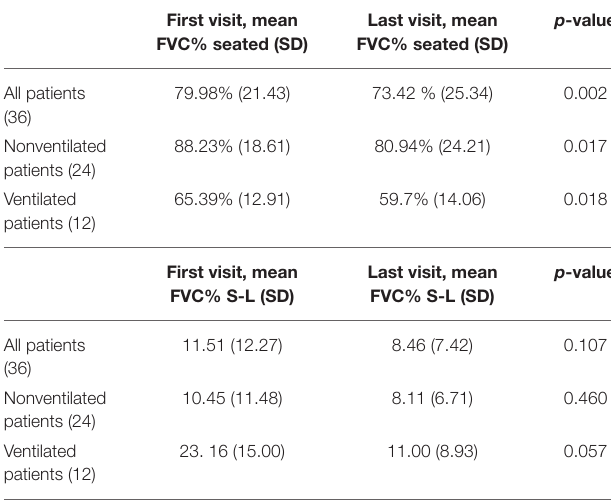
TABLE 4 | Mean values of the FVC measured seated and mean values of the differences between FVC seated and lying at the first and last visit. First visit, mean Last visit, mean FVC% seated (SD) FVC% seated